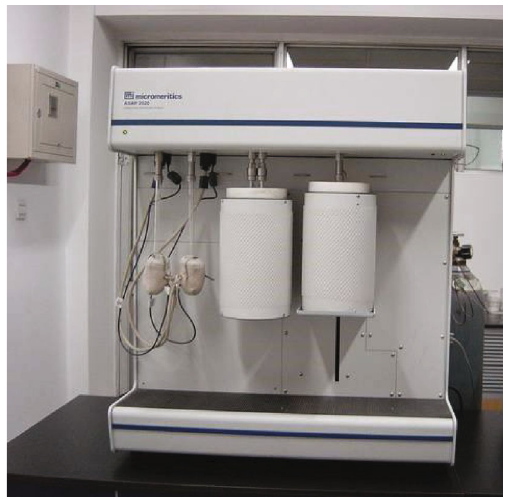
Figure 1: ASAP2020 instrument developed by Micrometrics.